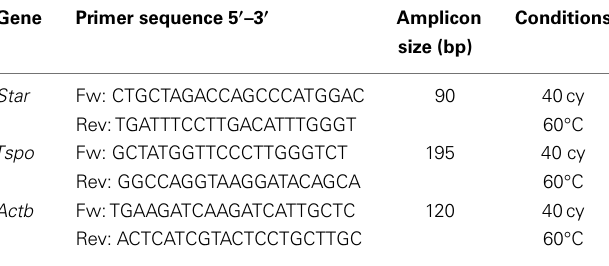
Table 2 |The primers and conditions used for qPCR.